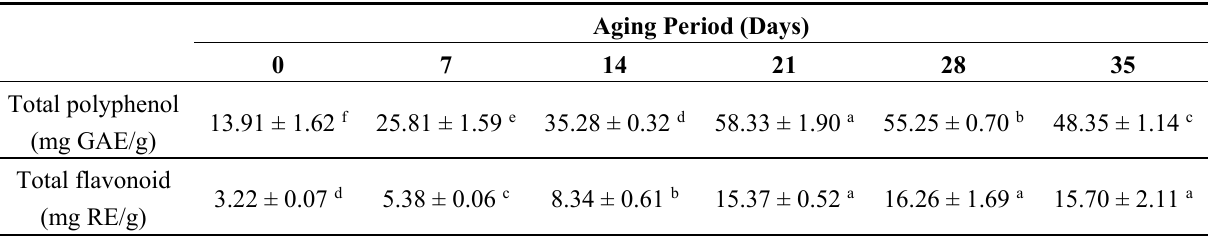
Table 3. Antioxidant contents of black garlic during aging